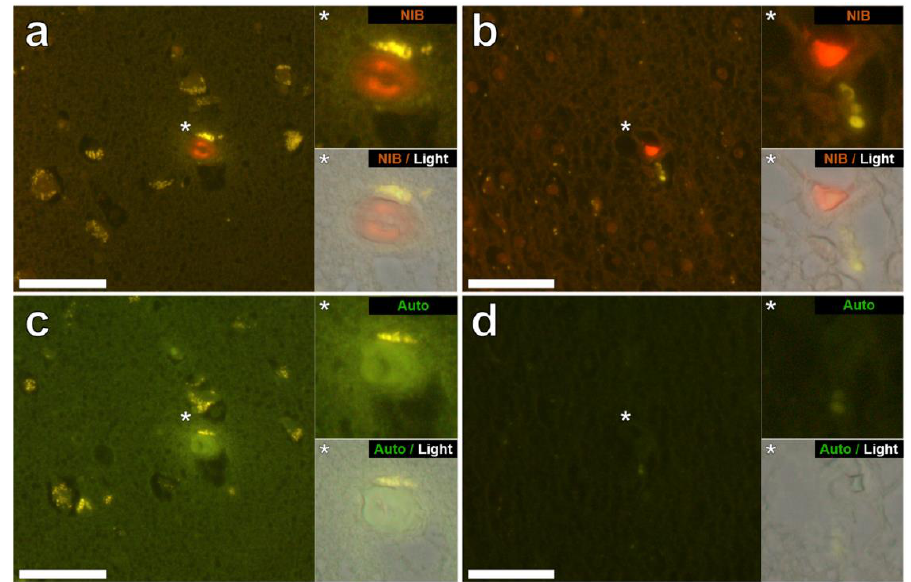
Figure 3. Aluminium in the frontal lobe and hippocampus of a 48-year-old female donor (MS317), diagnosed with SPMS. ( a ) Intense orange aluminium fluorescence was identified in refractile corpora amylacea (or mineralised deposits) in the frontal cortex (grey matter). ( b ) Intracellular aluminium was also observed in occasional glial-like cells in the parahippocampal gyrus (white matter). Autofluorescence of serial sections ( c , d ) confirms the identity of aluminium in ( a,b ) respectively. Upper and lower panels depict magnified inserts of the fluorescence channel and bright field overlay. Magnification ×400, scale bars: 50 μm.